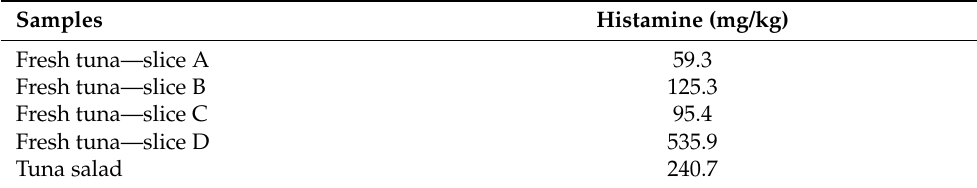
Table 5. Histamine concentrations detected in fresh tuna and tuna salad placed in contact with the cutting board previously used to cut tuna muscle naturally incurred with histamine at 8000 mg/kg (trial